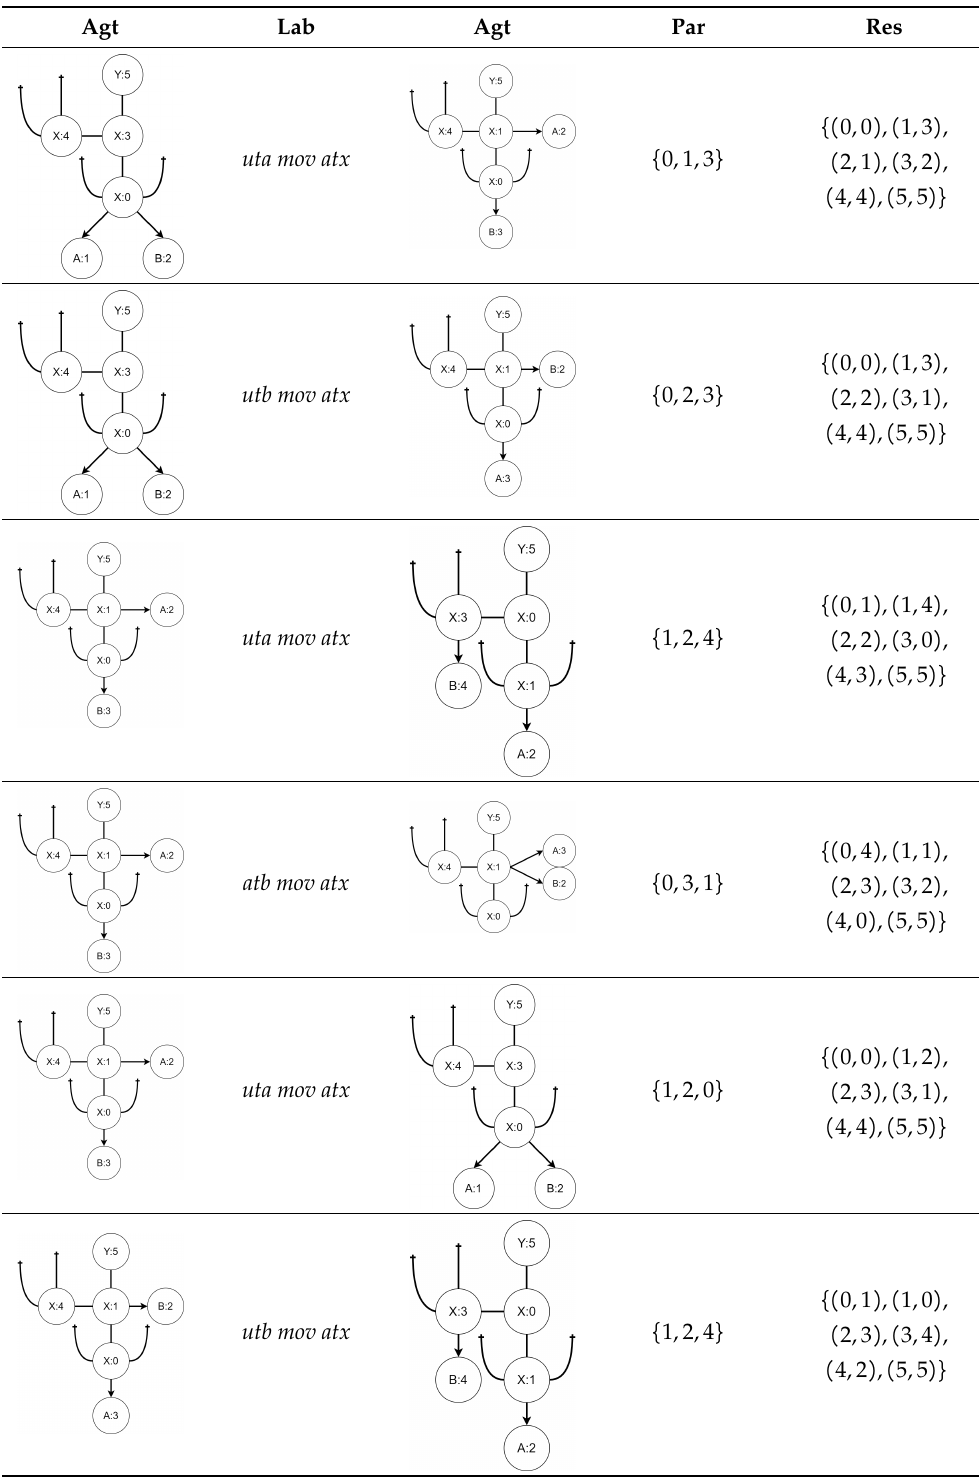
Table A1. The Tracking Transition System for scenario 1. Each row defines a single transition in the